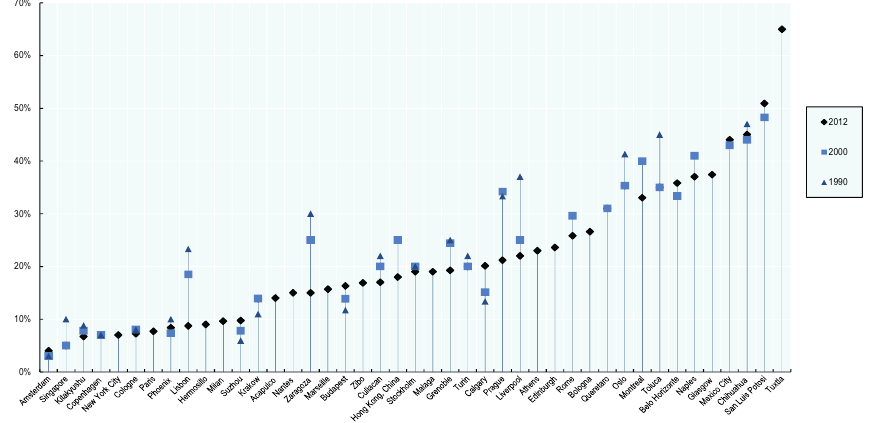
Figure 1. Proportion of water loss in surveyed cities (leakage